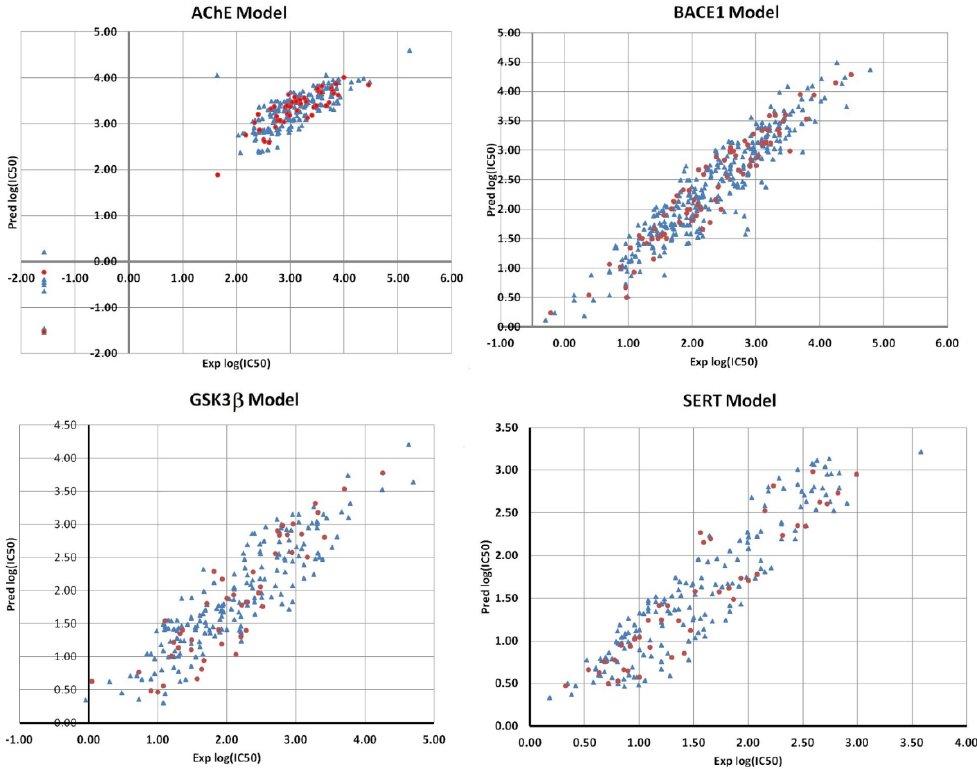
Figure 3. Scatter plots between predicted and experimental log (IC 50 ) values for all ANN models. Legend: training datapoints—blue triangles; validation datapoints—red dots. Legend: training datapoints—blue triangles; validation datapoints—red